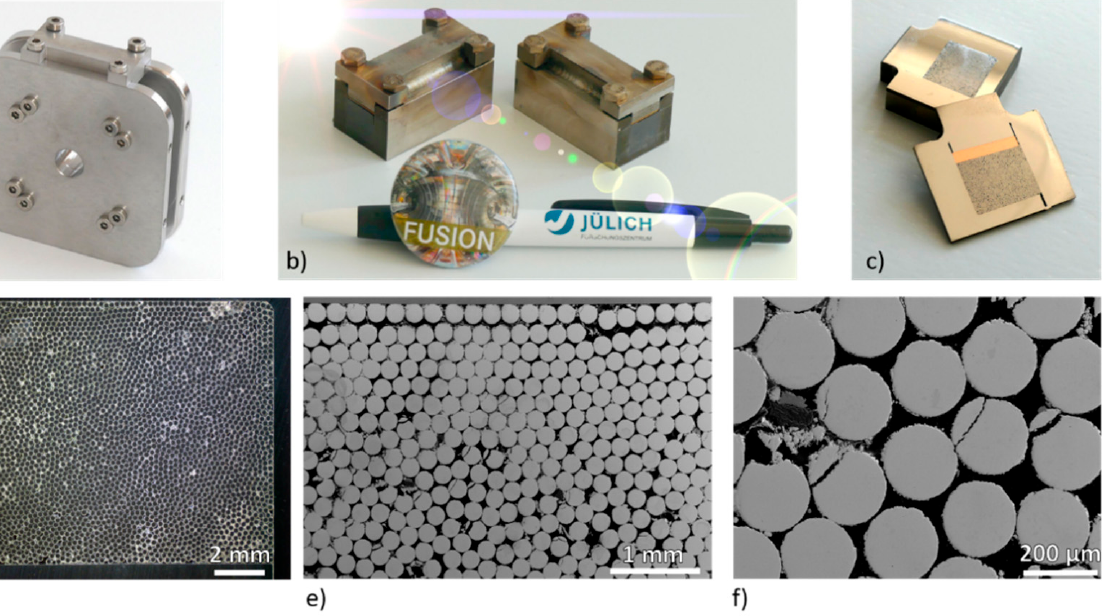
Figure 2. Manufacturing procedure is based on sectioning a spool ( a ) after winding the W-wire around and welding on clamps at the edges. The sections are shown in ( b ) and the surface of a typical W w slice after polishing in ( c – f ).